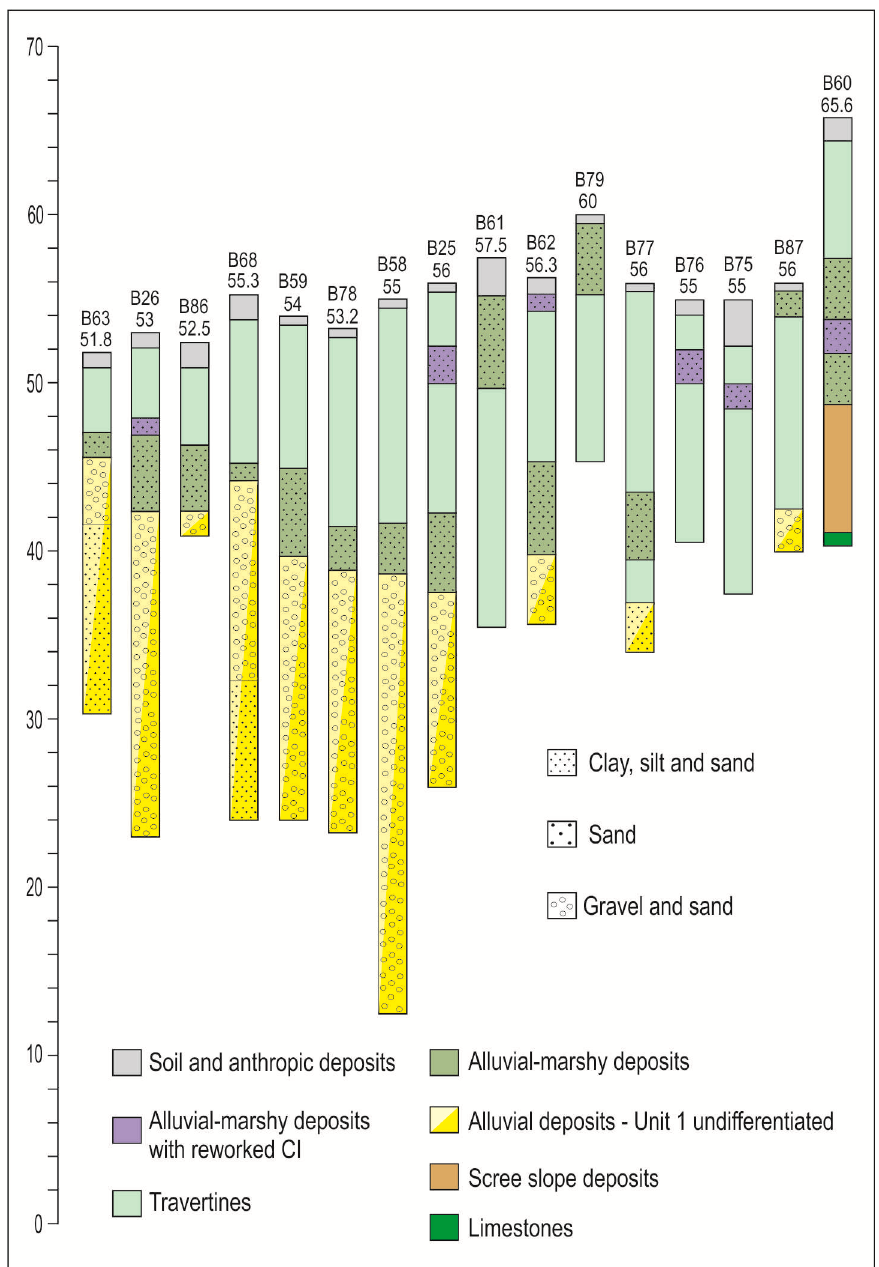
Figure 13. Stratigraphical logs of boreholes drilled on the T-T. For location of boreholes, see Figure 9. Along the Calore River, the valley floor terraces (VFT) are essentially represented by T2 and T3 (Figures 6 and 9). T1 terrace is only marginally present to the east of Telese, at 52 m a.s.l. (Table 3), and disappears immediately upstream Telese travertine terrace (T-T). Its altitude, close to that of the lower part of the T-T, suggests that its alluvial deposits are at least partly in lateral heteropy with the Telese travertines. T2 reaches a